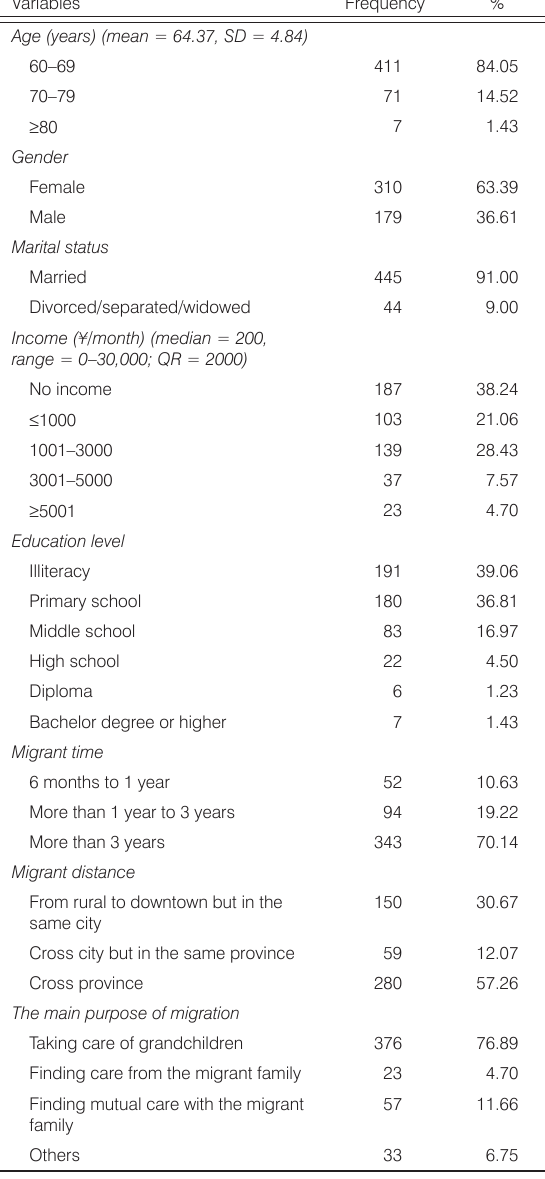
Table 1. Sociodemographic and migration characteristics of the migrant old parents (N =